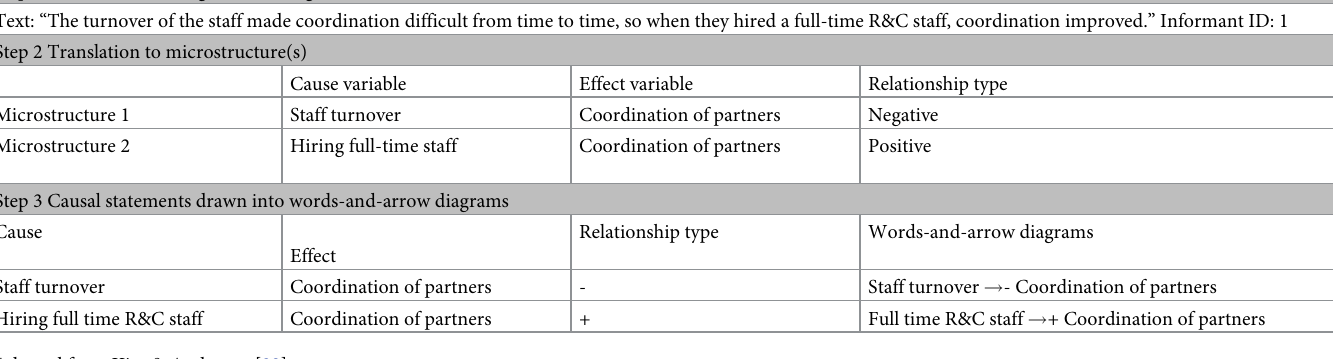
Table 1. Example coding chart to inform CLDs from interview